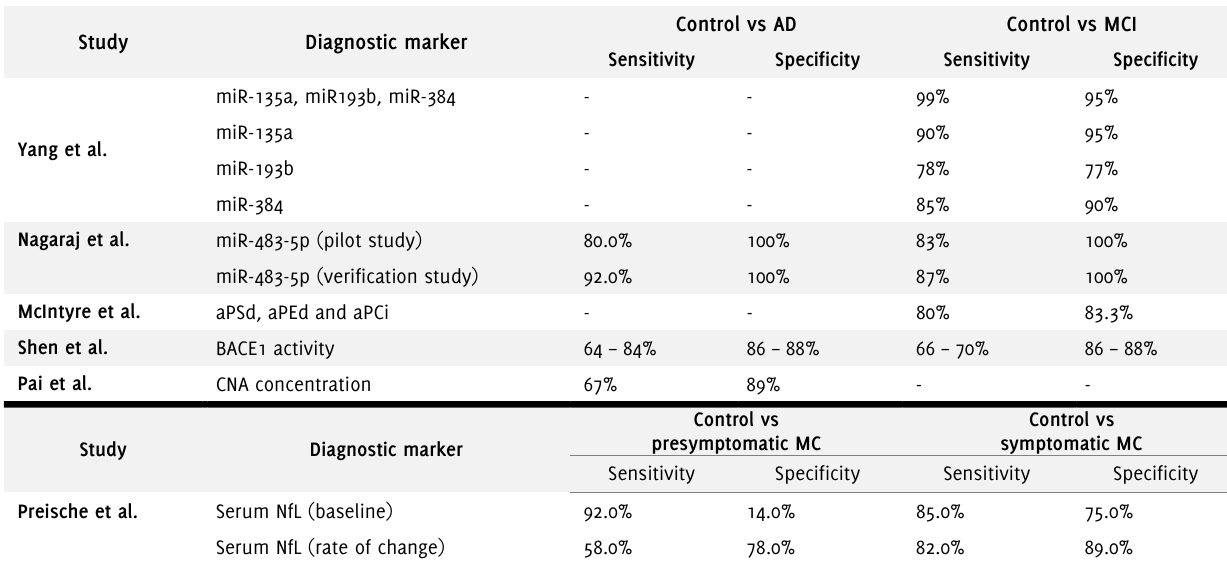
Table 5. Discriminative potential of novel biomarkers, quantified by measures of diagnostic